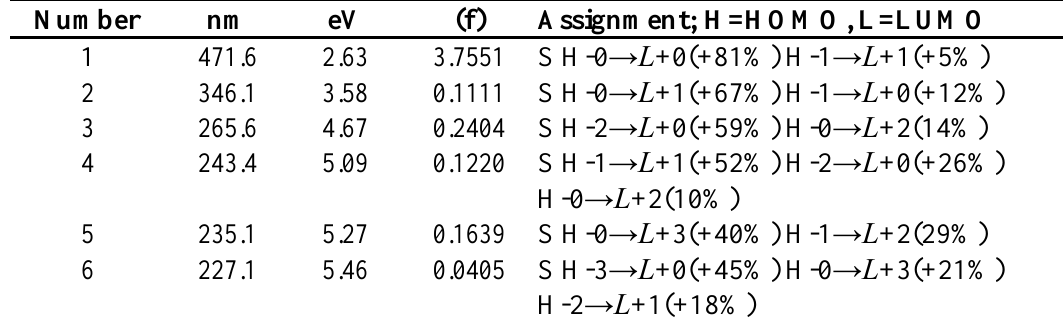
Table 2. Electronic transition states of bixin (nm, eV, oscillator strengths (f), and transition assignments as calculated with TD-DFT and the M05-2X/6-31+G(d,p) level of theory. Only the transition states with f > 0.02 are shown.